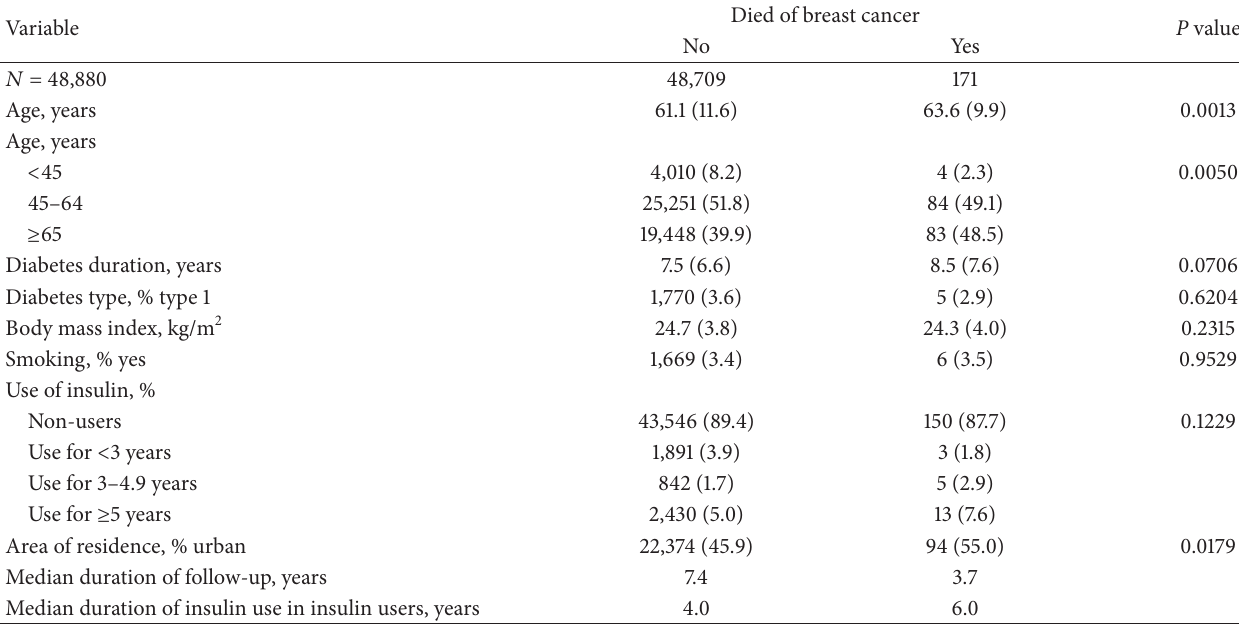
Table 1: Baseline characteristics of women with diabetes who died and those who did not die of breast cancer.